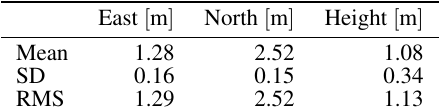
Table 7. Statistics of the differences between the image